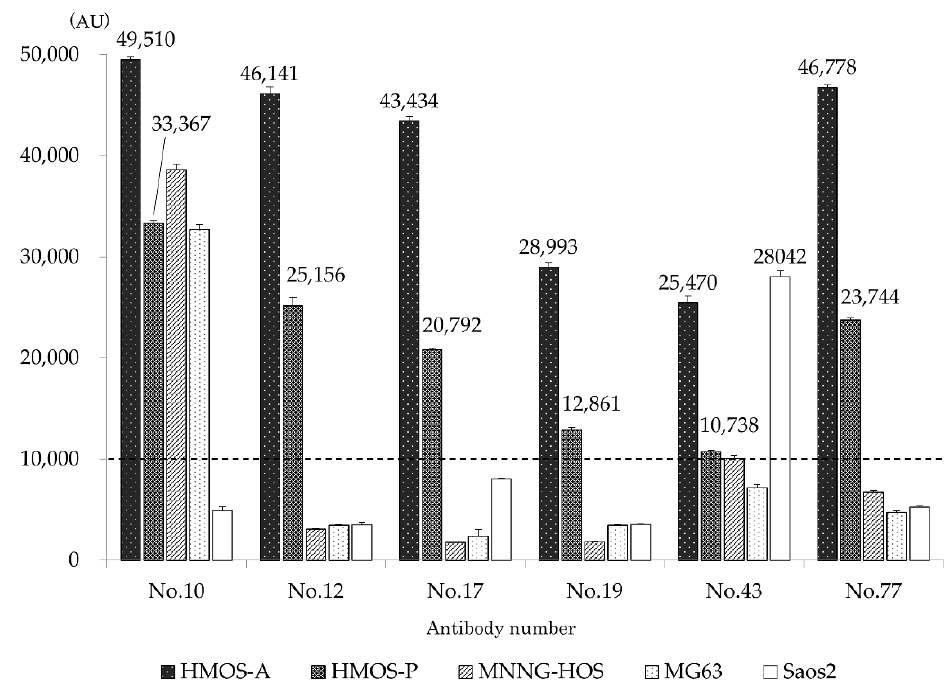
Figure 2. Comparison of antibody reactivities toward various cell lines. The six clones were also incubated with HMOS-P, the primary human multicentric osteosarcoma (HMOS-A), MNNG-HOS, MG-63, and Saos2, and the fluorescence intensity was measured using ELISA. All antibodies showed stronger fluorescence intensity, indicating greater reactivity with HMOS-A than with HMOS-P. Antibody numbers 10 and 43 were positive for MNNG-HOS. In MG63 cells, only antigen number 10 was positive, whereas only antigen number 43 was positive in Saos2